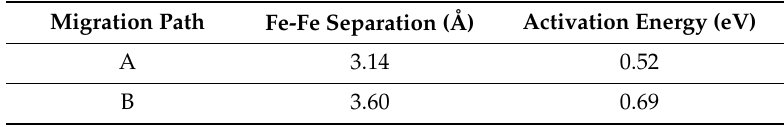
Figure 3. Possible long-range iron vacancy migration paths considered. Green and yellow color atoms correspond to di ff erent Fe hopping trajectories. Table 3. Fe-Fe distances and their corresponding activation energies for the Fe ion migration in FeTiO 3 , as reported in Figure